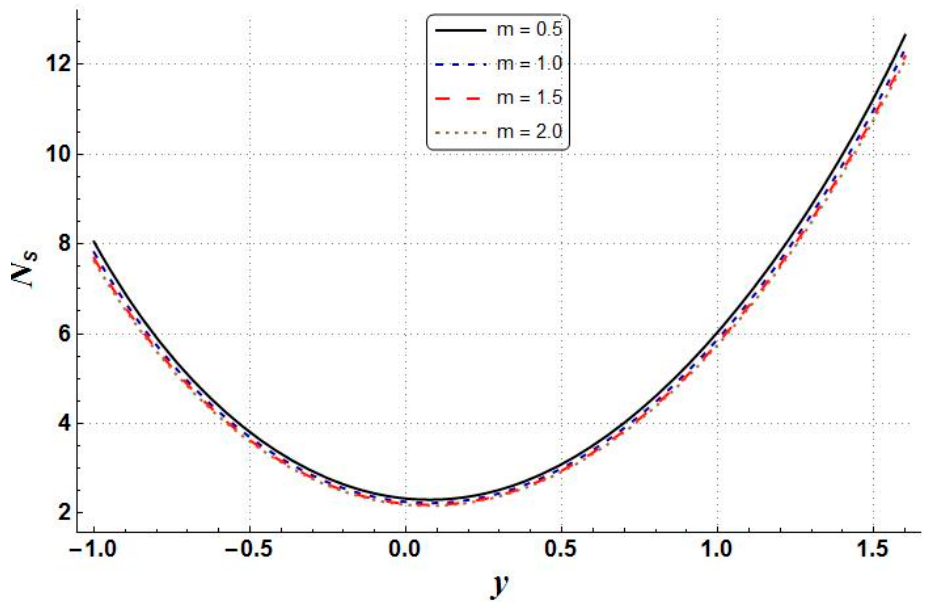
Figure 25. Influence on N S through changing values of m , where γ = π φ = 0.05, k = 2, a = 0.6, M = 1, d = 0.7, Br = 0.2, b = 0.5, ∈ = 2, η = 0.8.